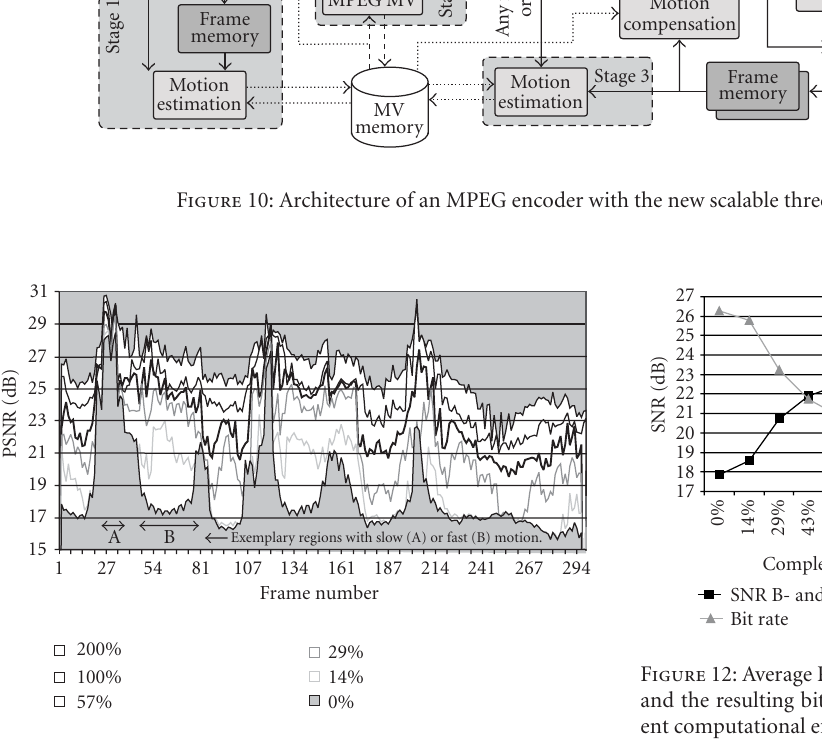
Figure 11: PSNR of motion-compensated B-frames of the “Ste- fan” sequence (tennis scene) at di ff erent computational e ff orts— P-frames are not shown for the sake of clarity ( N = 16, M = 4). The percentage shows the di ff erent computational e ff ort that re- sults from omitting the computation of vector fields in Stage 1 or performing an additional refinement in Stage 3.